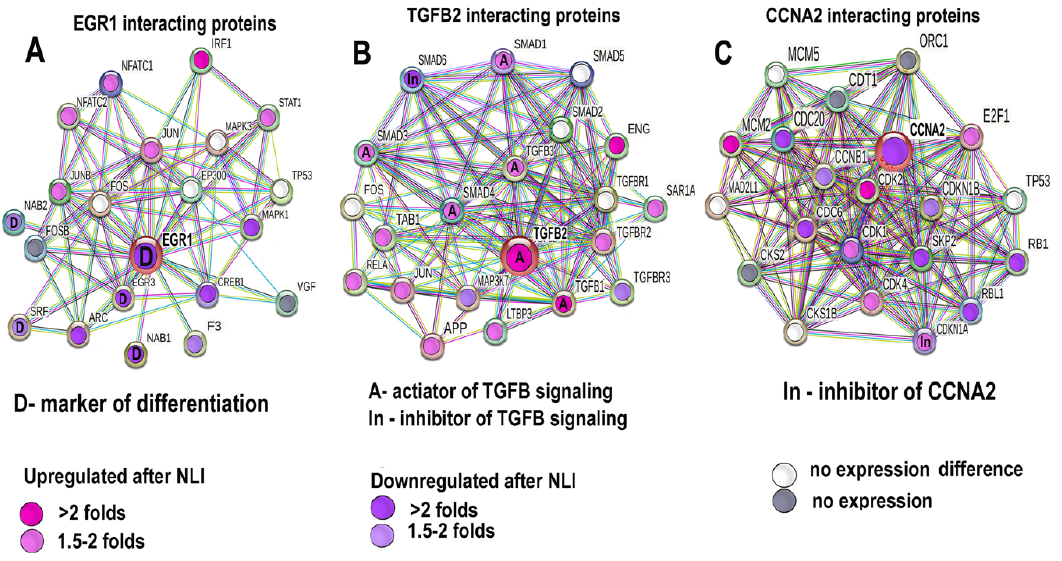
Figure 10. Protein interaction networks for proteins encoding for Egr1, Tgfb2, Ccna2, and their closest interactants matched with the data on the expression difference for the experiment vs. the control defined by mRNA–seq. ( A )—Protein interaction networks for Egr1. It can be seen that EGR1 decreases expression together with its direct regulators and markers of differentiation Nab1, Nab2, Egr1, and Srf [105–107]. ( B )—Protein interaction networks for TGFB2 indicates that Tgfb2 is upreg- ulated together with the upregulation of its activators Tgfb1, 3 and Smad 3, 4, and the downregula- tion of its inhibitor Smad 6 [108]. ( C )—Protein interaction network for Ccna2 demonstrates that work is constructed for the 20 closest interactants of Egr1, Tgfb2, and Ccna2.